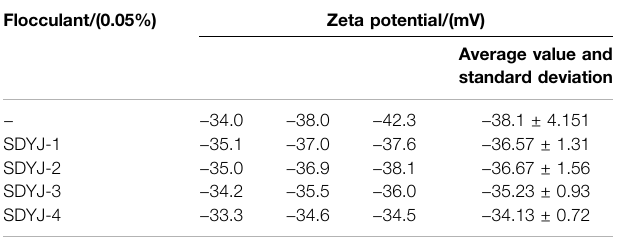
TABLE 11 | Effect of SDYJ-2 emulsion with different concentrations on the Zeta potential of PEM drilling fl uid. Flocculant concentration Zeta potential/(mV) Average value and standard deviation